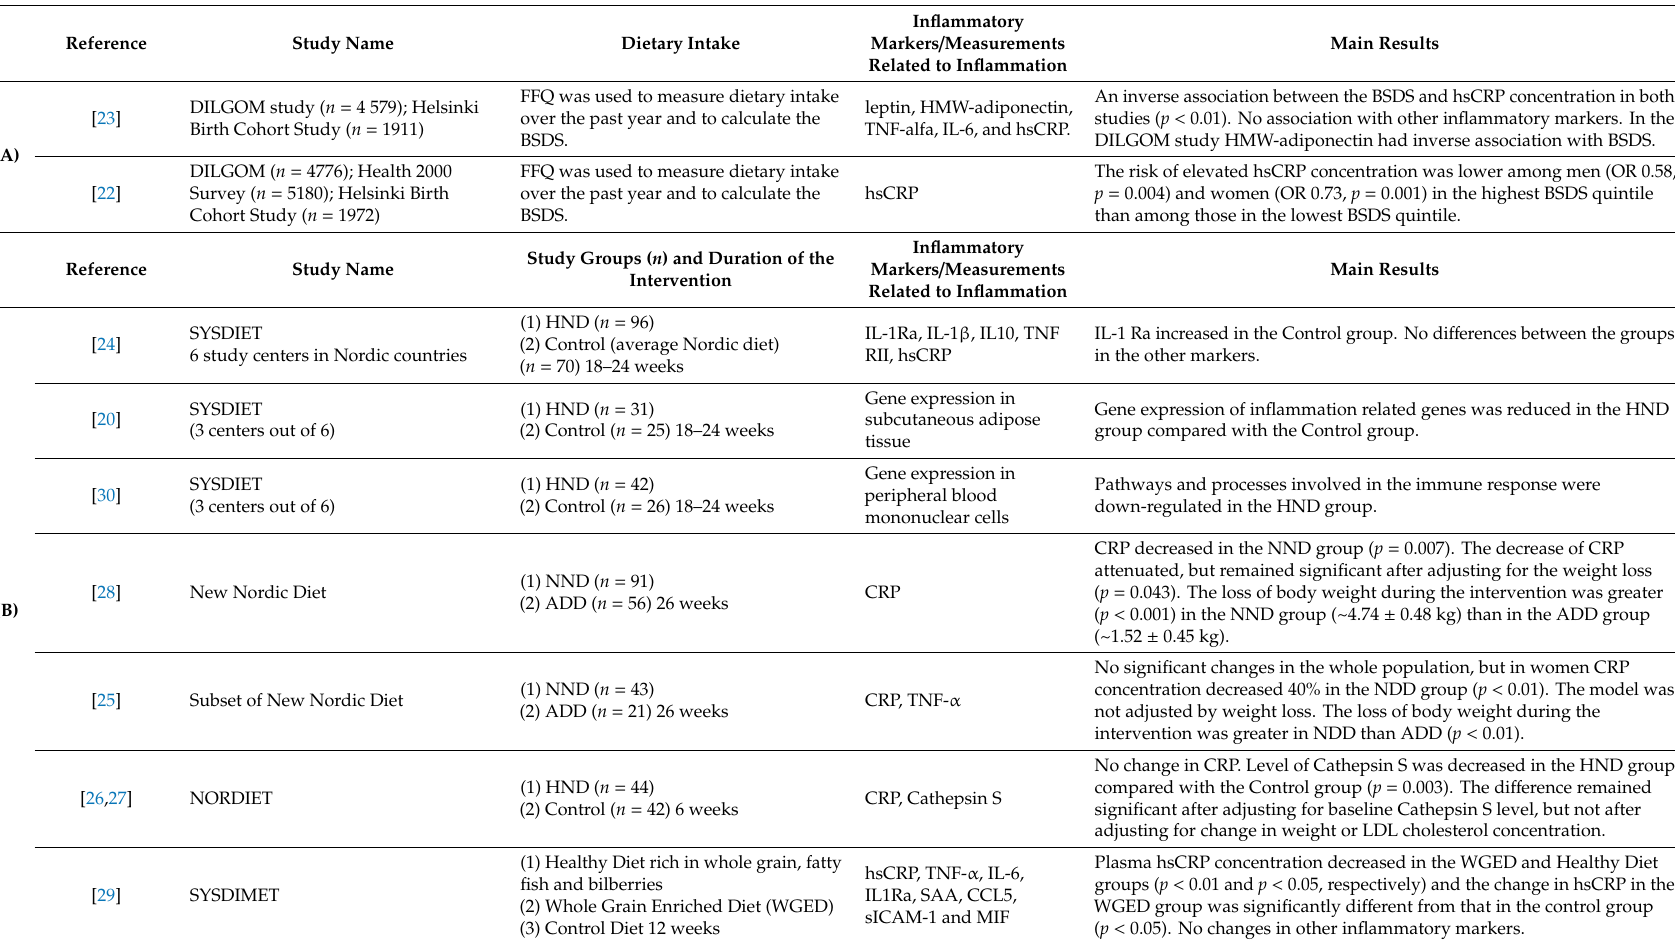
Table 2. Observational studies investigating association between the Nordic diet and inflammatory markers ( A ) and intervention studies investigating e ff ects of the Nordic Diet on inflammatory markers ( B